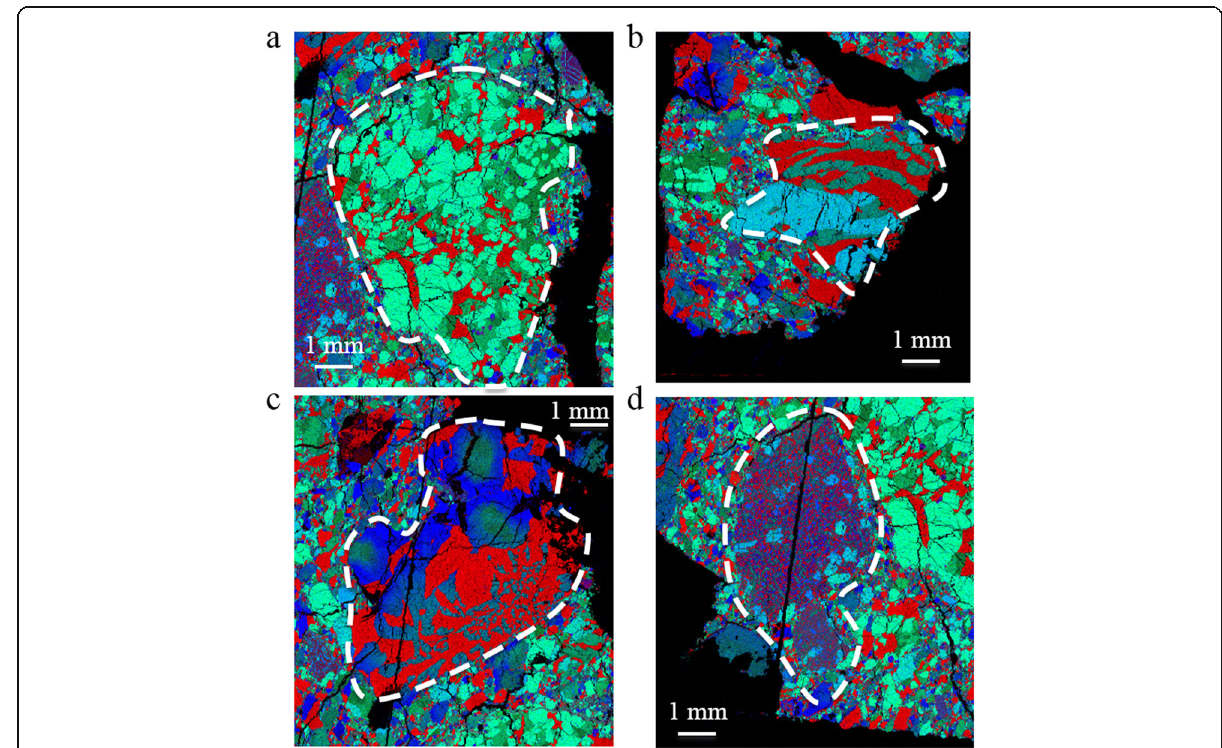
Fig. 2 False-color X-ray elemental images of mafic lithologies of NWA 2727. Detailed explanations of each figure are as follows: a olivine gabbro (OG); b anorthositic gabbro (AG); c pyroxene gabbro; d olivine-phyric basalt (OPB). RGB elemental map with R = Al, G = Mg, B =